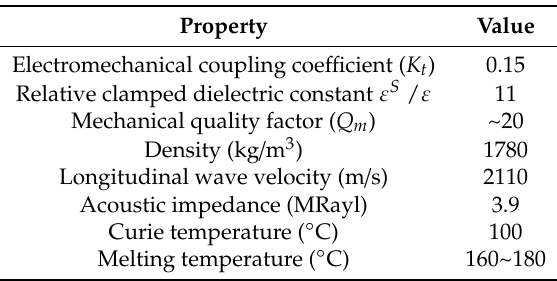
Table 1. Properties of PVDF 1 material.